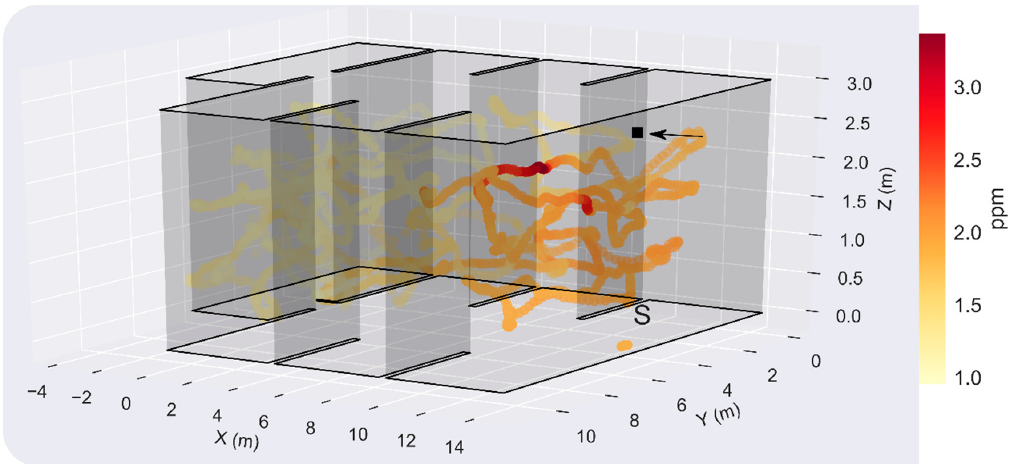
Figure 17. 3D map of the instantaneous concentration (ppm) in Experiment 2. The black square indicates the gas source location ( x,y,z ) = (14.0, 5.2, 2.7) m, the black arrow the wind direction (positive x-axis) and the letter ‘S’ the starting point of the drone ( x,y,z ) = (13.5, 5.2, 0.0) m.